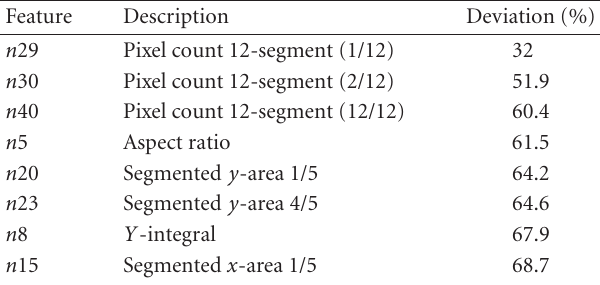
Table 3: Features showing a low intravariability for N = 6 with the semantic class being signature.